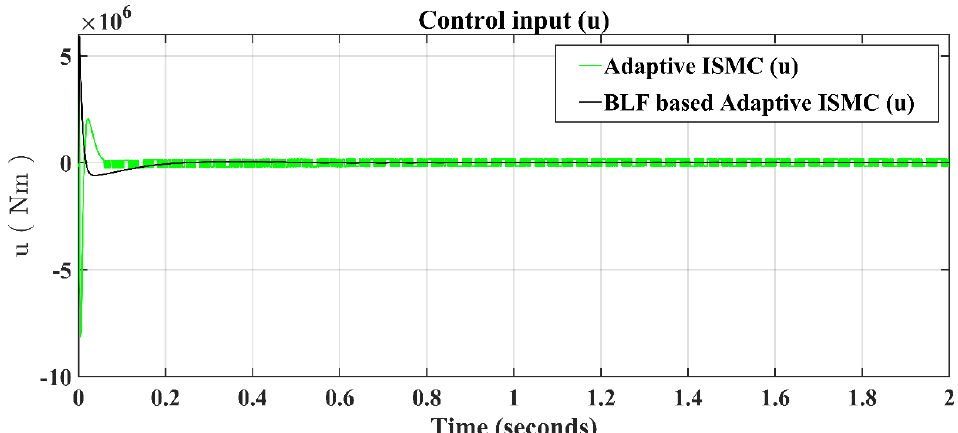
Figure 6. The response of the proposed control inputs, where green represents adaptive backstepping ISMC efficiency and black represents BLF − based adaptive backstepping ISMC efficiency.